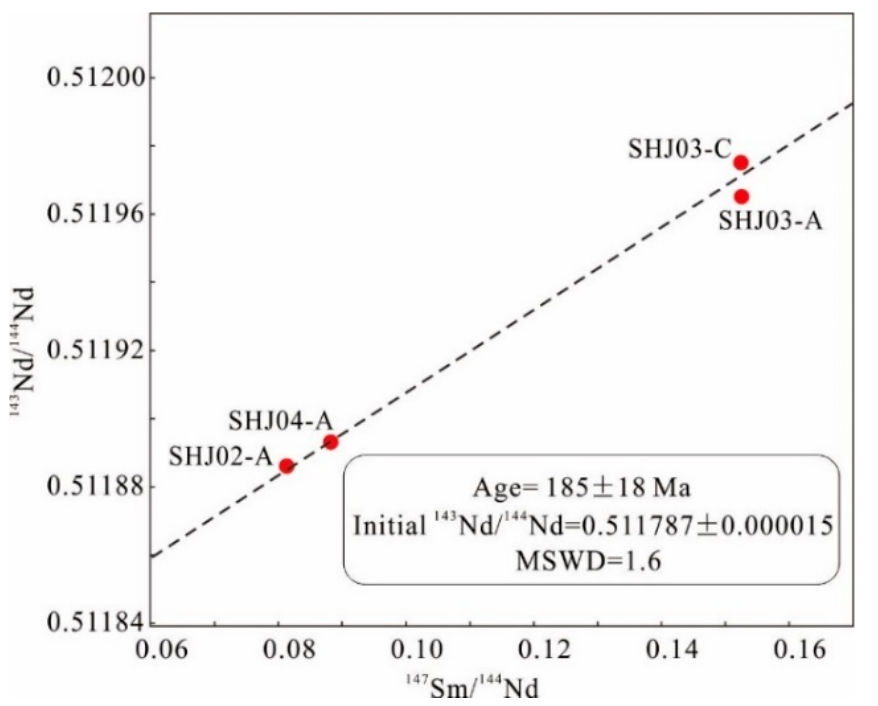
Figure 6. Fluorite Sm-Nd isochrons of the Shuanghuajiang fluorite deposit. Table 2. Fluorite Sm and Nd isotopic compositions of the Shuanghuajiang fluorite deposit. Sample No.